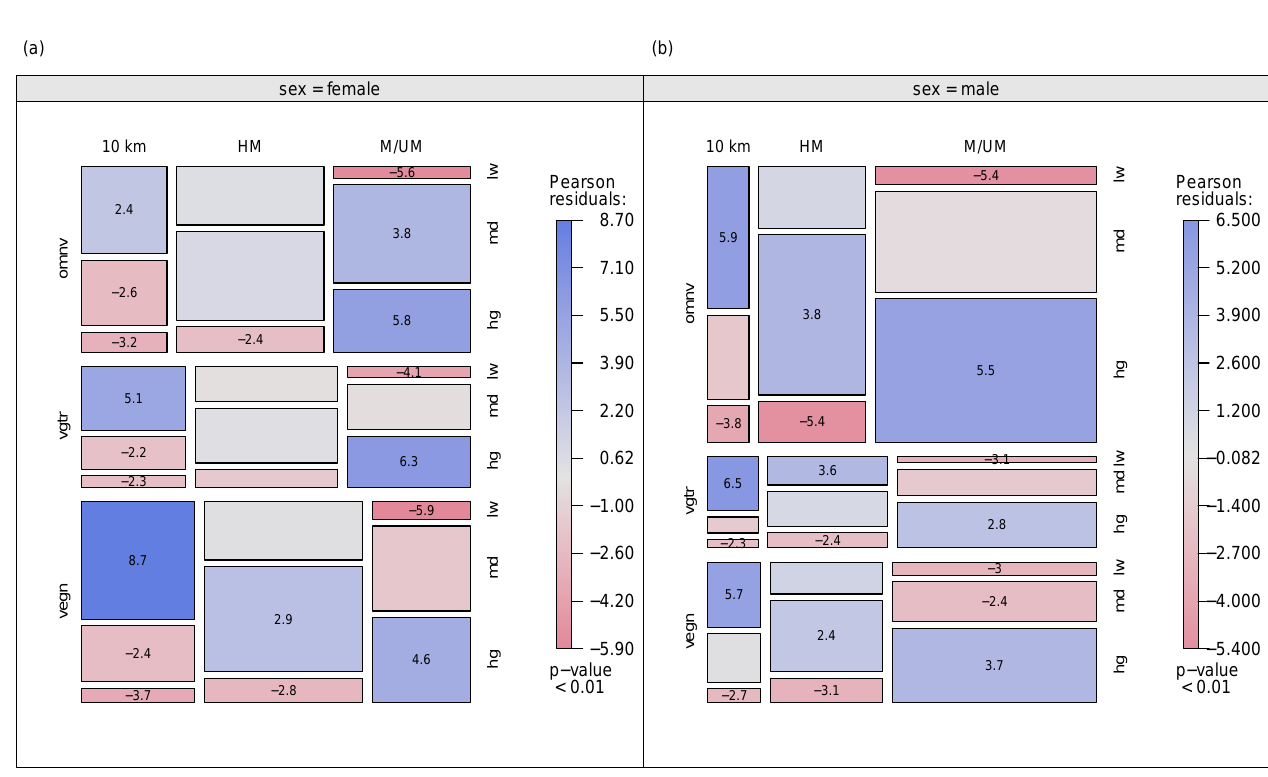
Figure 3. Association between Race Distance, Dietary Subgroup, and Training Mileage displayed by ( a ) Female Endurance Runners and ( b ) Male Endurance runners. Note: Exceptionally (significantly) high values are visualized with blue and strikingly (significantly) low values are visualized with red. <21 km—less than half-marathon; HM—half-marathon; M/UM—marathon/ultra-marathon. vegn—vegans: avoid all foods and ingredients from animal sources; vgtr—vegetarians: avoid all flesh foods but consume egg and/or dairy products; omnv—omnivores: have no restriction on source of